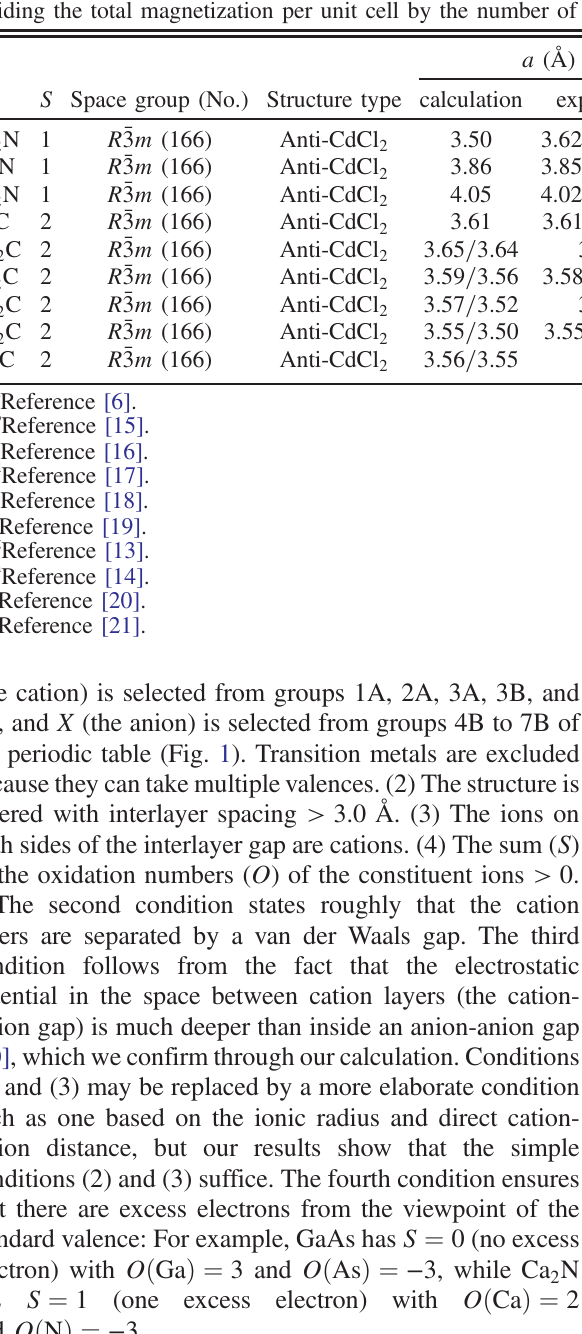
FIG. 2. (a) Crystal structure (anti-CdCl 2 structure) of Ca 2 N. The large and small spheres denote Ca and N ions, respectively. A conventional unit cell in the hexagonal setting (lattice vectors ~a , ~ b , and ~ c ), containing three primitive rhombohedral cells, is shown by solid lines. (b) BZ for the rhombohedral Bravais lattice and the k path (solid lines) used to plot the band structure in the present paper [22]. In the 2D limit, the BZ in (b) approaches the hexagonally shaped zone in